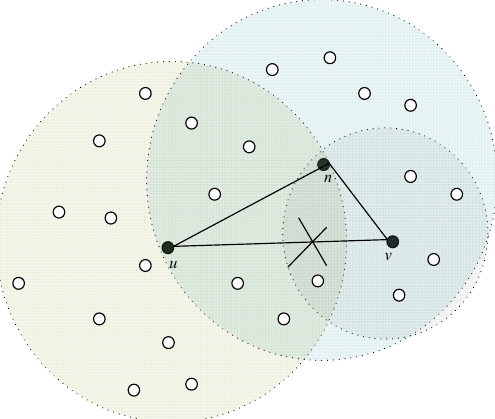
Figure 4. Interference after adjusting the transmission range.